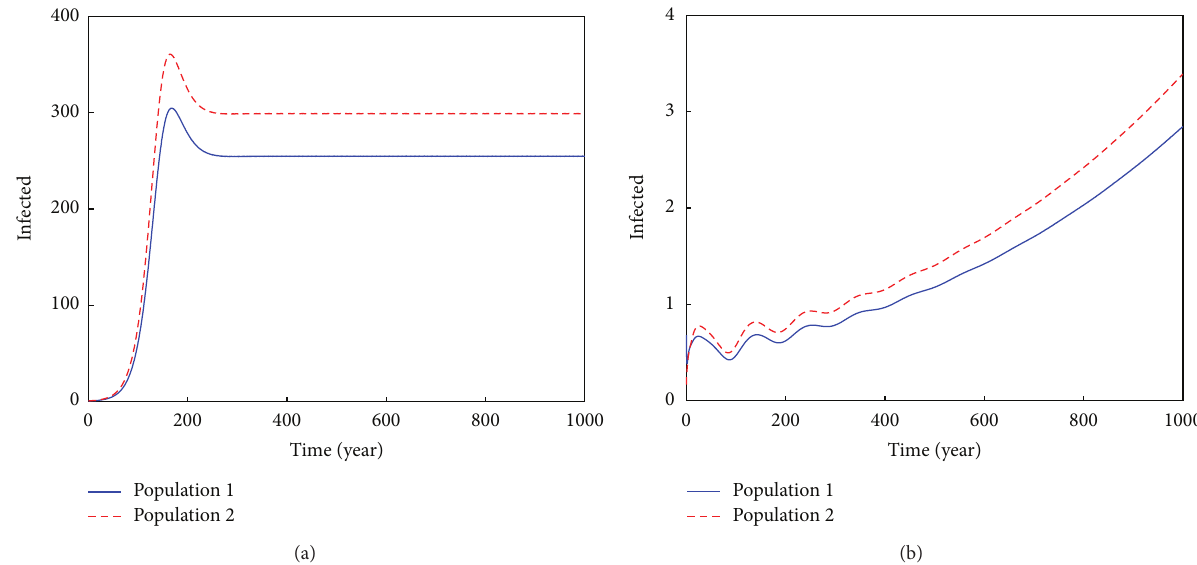
Figure 8: (a, b) Trajectories of infectious individuals in care center of (1) for different initial conditions. The endemic equilibrium exists and is stable when 𝑅 0 > 1 ; the DFE is unstable in this case.